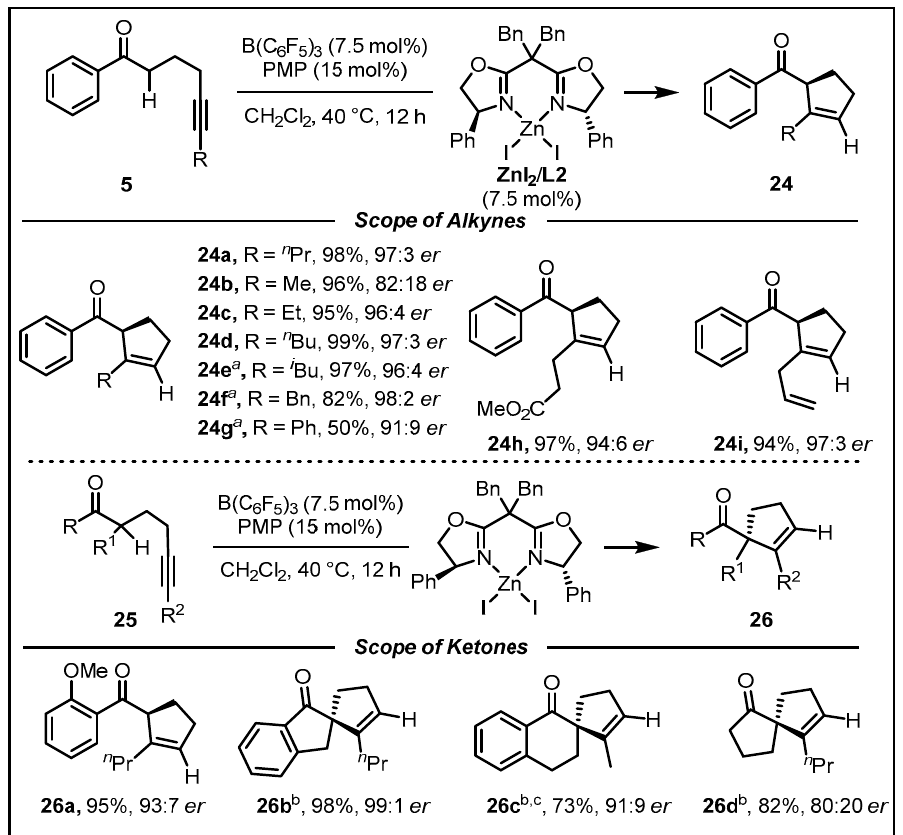
Figure 10. Enantioselective Conia-Ene-type cyclizations of alkynyl ketones. Showing that by tuning of different features of Lewis acids that possess overlapping